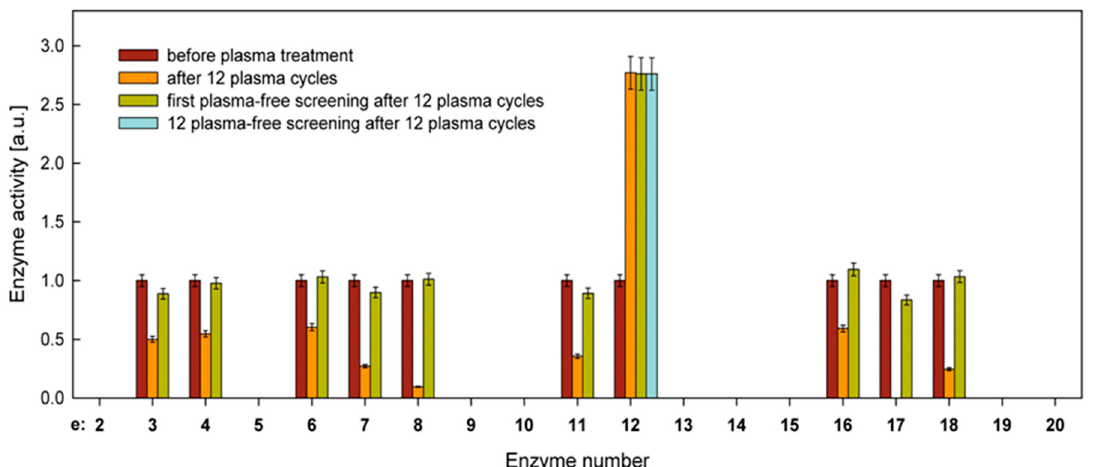
Figure 4. Summary of normalized activities of hydrolytic enzymes for C. albicans , before plasma treatment, after 12 plasma cycles, and after subsequent plasma-free screenings. All activity values for active enzymes before plasma treatment were normalized to 1.